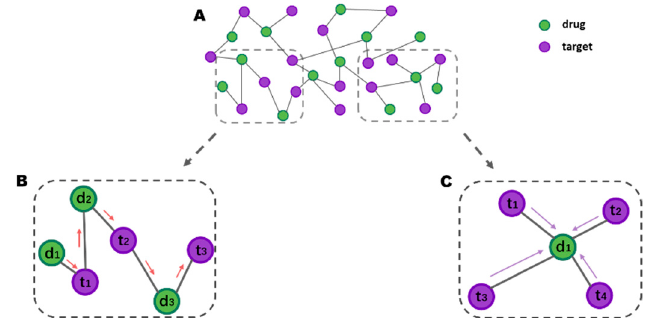
Figure 2. An example of large-scale graph representation learning. ( A ) The schematic diagram of the relationship between drugs and targets. ( B ) An example of the graph embedding in drug–target interactions (DTIs). ( C ) An example of the graph convolutional network.